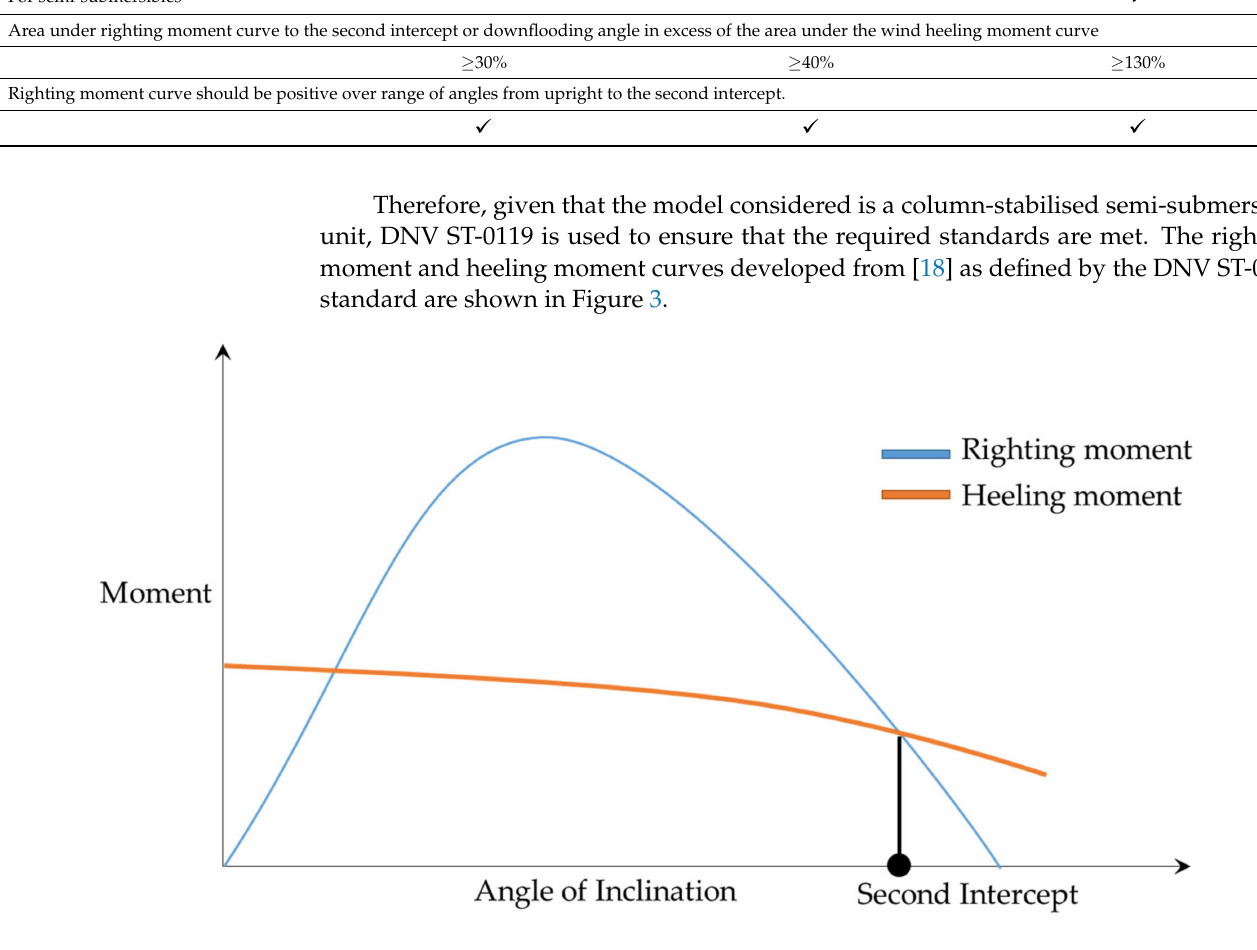
Table 2. Requirements set by standards.